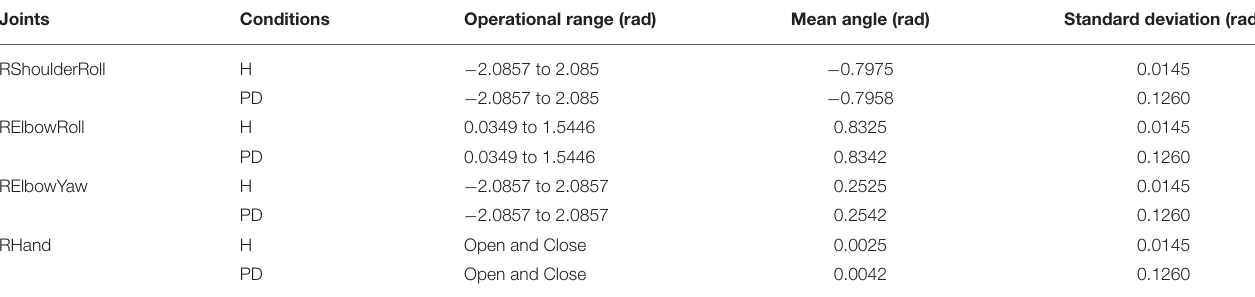
TABLE 1 | The fluctuation of the joints through the first 30 s of the experiment. Joints